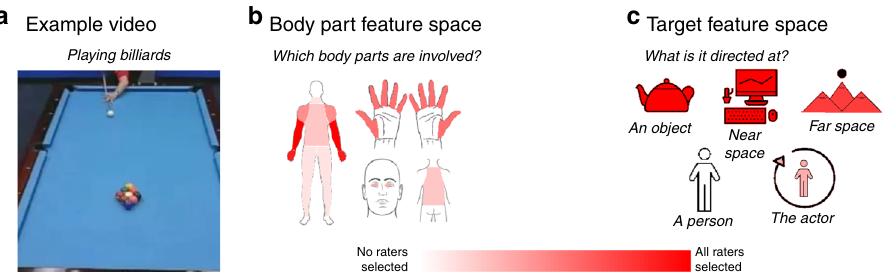
reliably responding voxels were predicted by fi tting tuning weights to body part and action target features. Voxel responses were predicted well across much of the ventral and dorsal streams (median r CV-set1 = 0.41 and r CV-set2 = 0.42; max r CV-set1 = 0.76. r CV-set2 = 0.71; see Supplementary Fig. 4 for results in individual